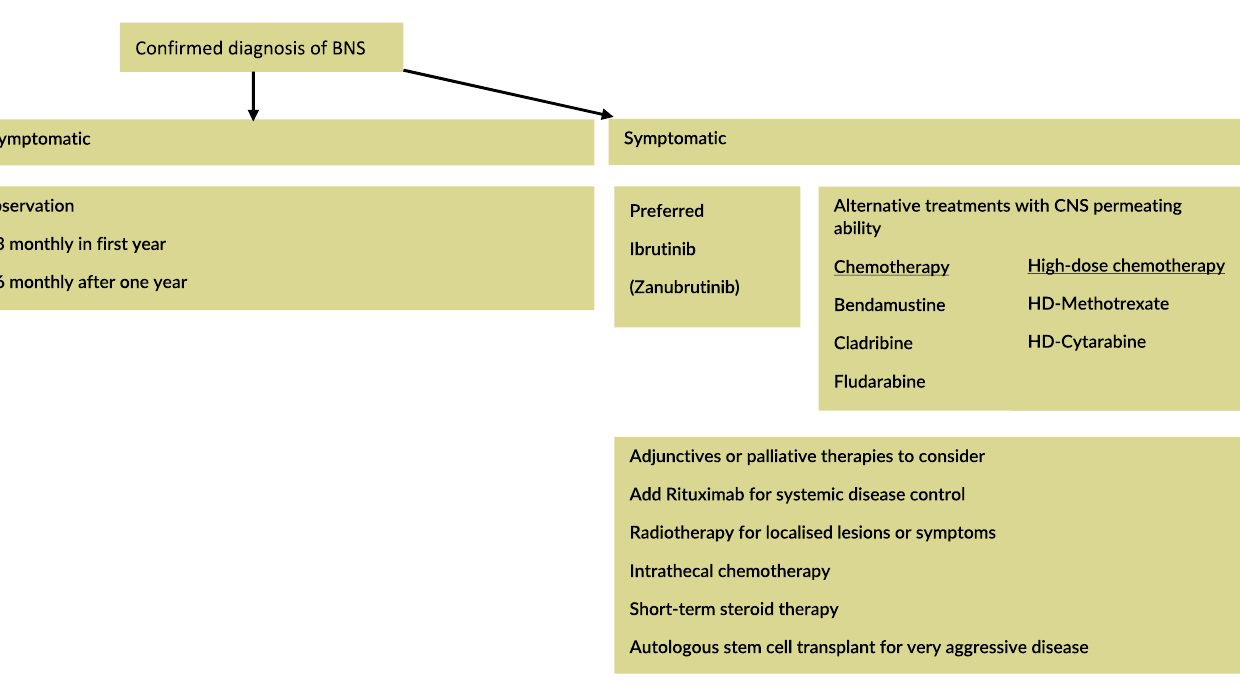
Figure 2. Therapeutic strategy for confirmed diagnosis of BNS. BNS—Bing–Neel syndrome; HD—high-dose. Adapted from Ref. [18]. Table 4. Pretreatment considerations in the management of Bing–Neel